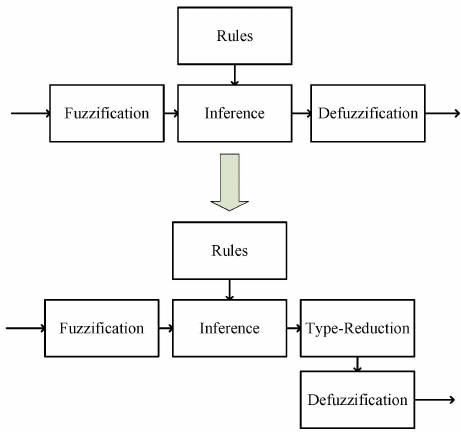
Figure 2. Type-1 and Interval Type-2 Mamdani Fuzzy Inference Systems.